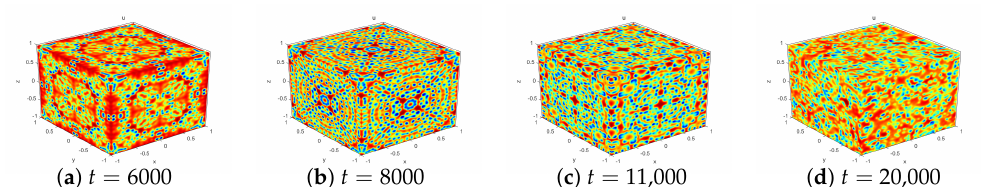
Figure 16. The patterns of u at K u = 2 × 10 − 5 , K v = 1 × 10 − 5 , F = 0.02, k = 0.055, N = 128, and α = β = 1.8 for Experiment